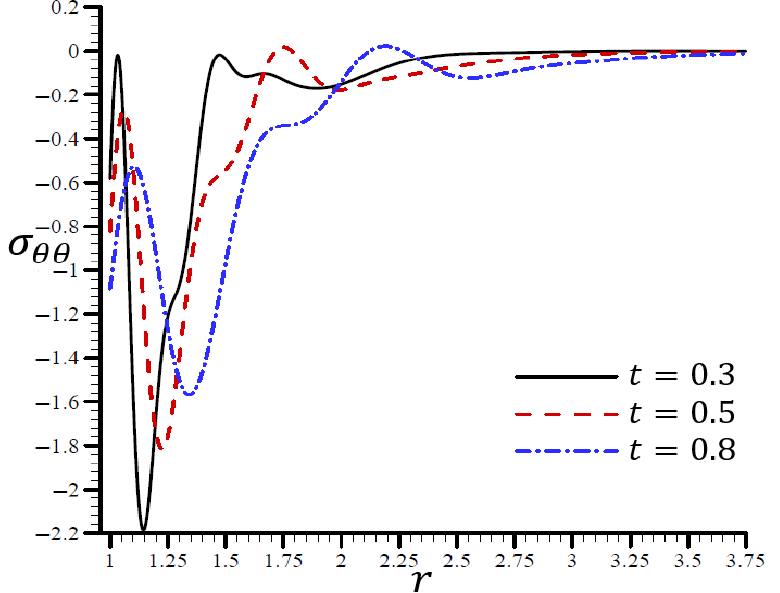
Figure 11. The influence of t on circumferential stress σ ΘΘ through the radial direction of the spherical hole using the RTPL model.